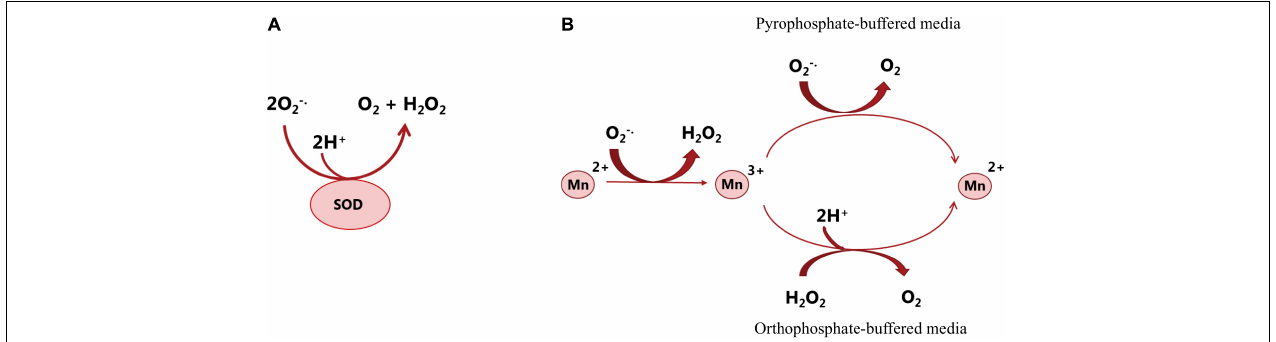
FIGURE 3 | Dismutation of superoxide (O2 – ) by superoxide dismutase (A) or manganese (B) . SOD reacts with O 2 – and generates H 2 O 2 and O 2 that are less reactive (Melo et al., 2011). Studying the catalytic activity of manganese in different in vitro systems (in pyrophosphate or orthophosphate-buffered media) showed that in both situations, Mn 2 + is oxidized by O 2 – , which forms Mn 3 + and H 2 O 2 and then the formed Mn 3 + is re-reduced to Mn 2 + , and O 2 is produced. In the presence of pyrophosphate, O 2 – acts as both oxidizing and reducing agent; in the presence of orthophosphate or some other buffered media, another reductant such as NAD(P)H or H 2 O 2 is required for the scavenging activity of manganese. The above-mentioned mechanisms potentially occur in the bacterial cell. However, the reaction rate and the reaction course are determined by the ligands that are available and can associate with manganese (Archibald and Fridovich,